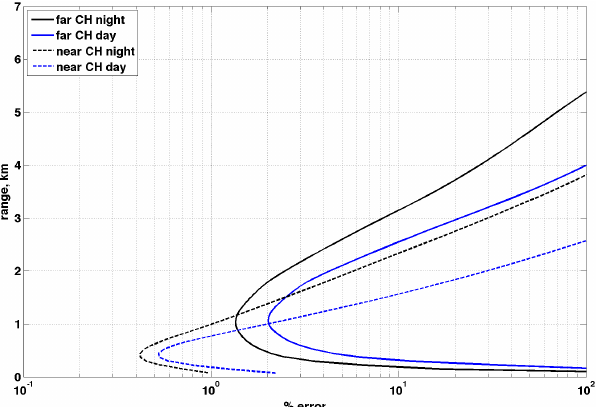
Figure 6. Performance estimate for day and night with 150m range resolution and 10min averaging for the near- and far-range channels for an online column OD of 1.5. For a 10% error, the instrument has a typical daytime range of ≈ 2.5km with this spatial and temporal averaging.